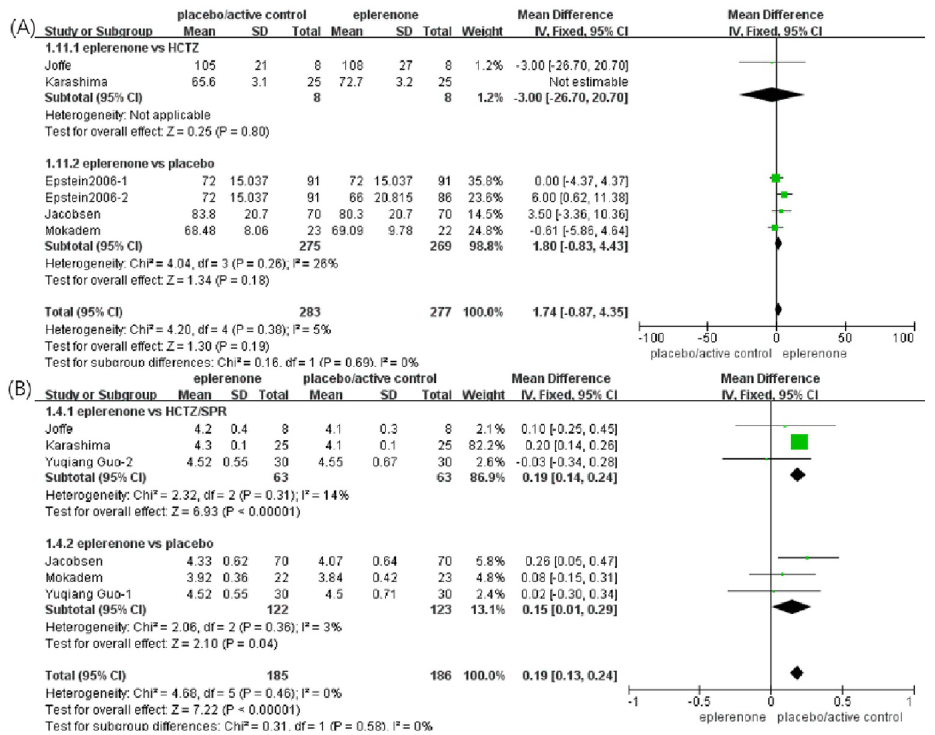
Fig 4. Forest plots of the effects between the eplerenone treatment groups and the controls. (A) Effect on eGFR in articles comparing eplerenone to placebo/active control. (B) Effect on serum potassium levels in articles comparing eplerenone to placebo/active